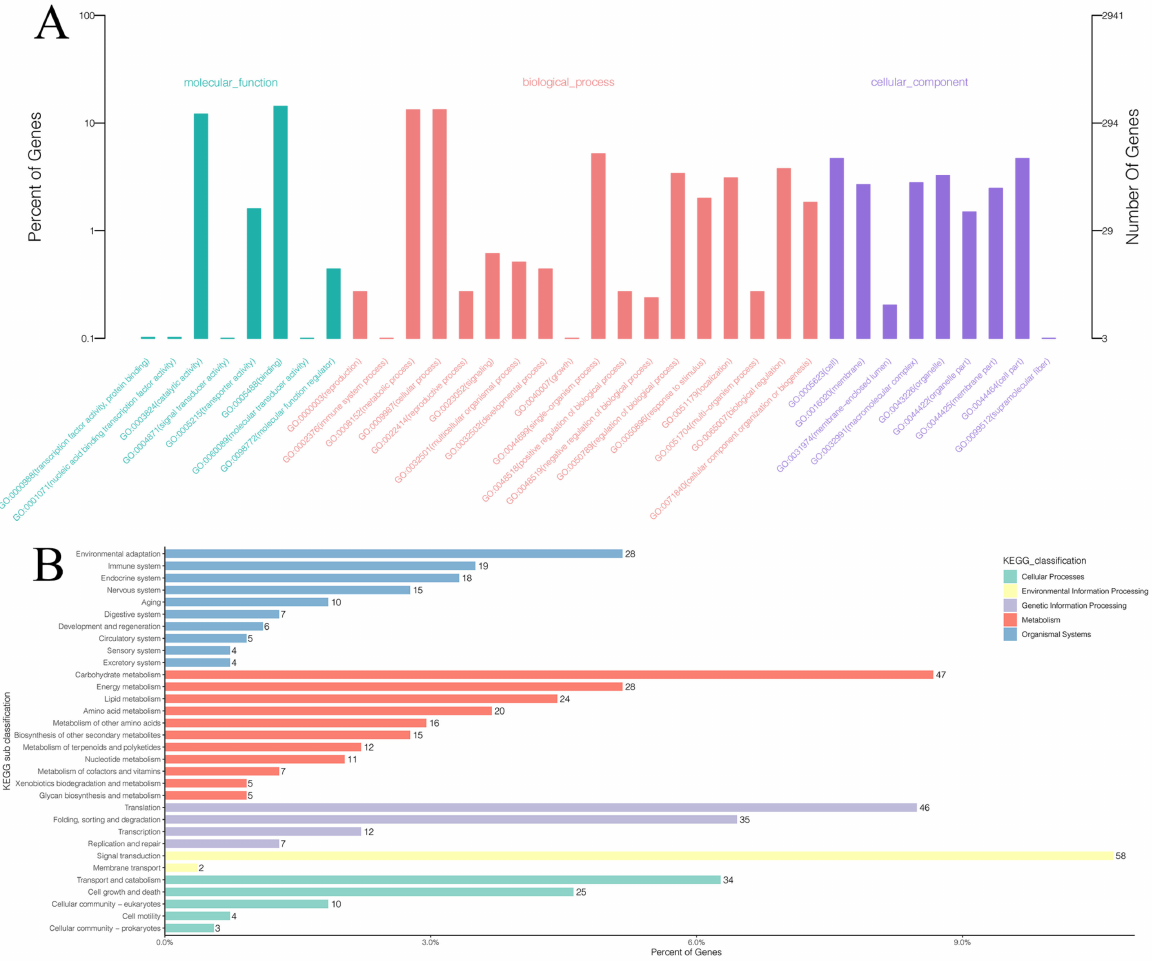
Figure 6. GO and KEGG enrichment of genes in the selective sweep regions between subgroup B and C. ( A ): GO enrichment; ( B ): KEGG